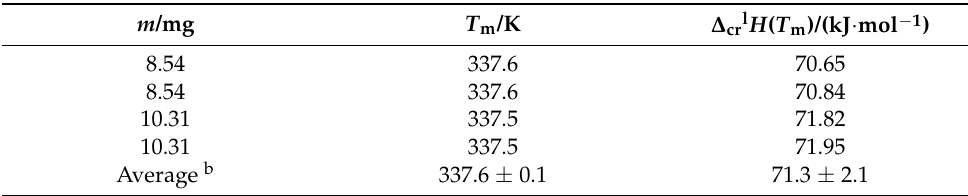
Table 1. The enthalpies and temperatures of fusion of n -octadecanophenone determined in this work by DSC at 0.1 MPa a .